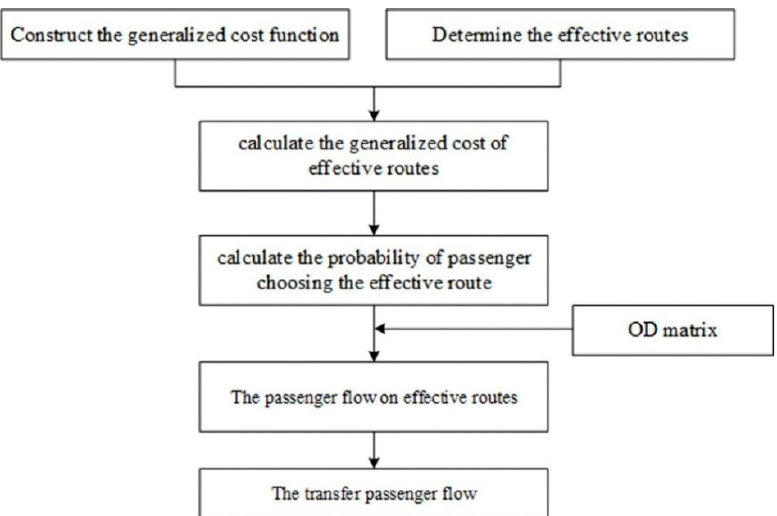
Figure 2. The flow chart of nested logit passenger flow assignment